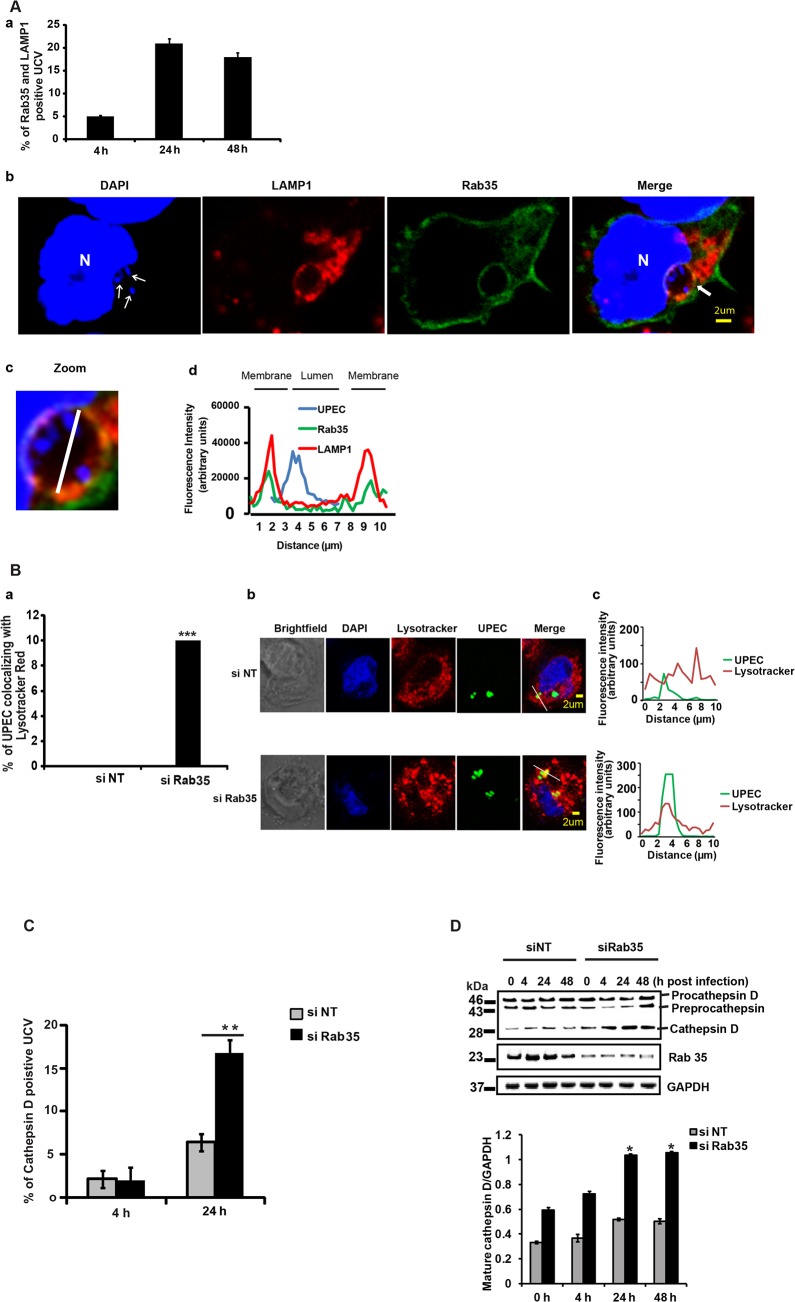
Loss of Rab35 targets UPEC to late lysosomal compartment.
A. BEC-5637 cells were transfected with Rab35 expressing plasmid. 24 h later the cells were infected with UPEC. The cells were fixed at different stages of infection, permeabilised and stained for LAMP1 and were then analyzed by confocal microscopy. The results (panel a) are represented as % of UCV positive for both Rab35 and LAMP1. At least 100 UCV were counted for each experiment. A representative image is shown in panel b. DAPI {blue, host nuclei (N) or bacteria (UPEC)}, Rab35 (green), and LAMP1 (red). Arrows in the DAPI panel indicates UPEC. Zoomed panel (panel c) shows the magnified image of UCV (marked by arrows in the merged image) {(optical magnification (63x) and electronic zoom (2.5x)}. The graph (panel d) shows the quantification of the fluorescence intensity along the white line shown in the zoomed panel. Both LAMP1 and Rab35 co-localized at the UCV. B. si NT and si Rab35 cells were infected with GFP-UPEC. At 24 h post infection, the cells were stained with LysoTracker Red for 2 h; fixed and analyzed by confocal microscopy. Graph (panel a) is depicted as % bacteria co-localizing with LysoTracker Red, At least 100 bacteria were counted. Representative images are shown in panel b (si NT) and (si Rab35). *** represents p<0.001, Values shown represent mean ± standard deviation of results of three independent experiments. The graphs (panel c) show the quantification of the fluorescence intensity along the white line shown in the merged image. UPEC from si NT sample did not co-localize with LysoTracker Red; while UPEC from si Rab35 sample co-localized with LysoTracker Red. C. BEC cells were transfected with si NT or si Rab35. 24 h later the cells were transfected with RFP-Cathepsin D expressing plasmid. After another 24 h the cells were infected with GFP-UPEC. The colocalization between UPEC containing vacuole (UCV) and Cathepsin D was observed 24 h post infection by confocal microscopy. Results are represented as % of cathepsin D positive UCV (% of UCV that is positive for cathepsin D). At least 100 bacteria were counted. ** represents p < .01, Values shown represent mean ± standard deviation of results of three independent experiments. D. Cathepsin D protein expression was analyzed in si NT/ si Rab35 cells left uninfected or infected with UPEC for 4, 24 and 48 h by Western blotting. The experiment was repeated three times with similar results and a representative blot is shown (top panel). Quantitation of the Western blots using the software ImageJ is shown (bottom panel). Relative densitometric data (mature cathepsin D/GAPDH) is shown. Values shown represent means ± standard deviations of results of three experiments. (* p<0.05 vs siNT values at the corresponding time points).